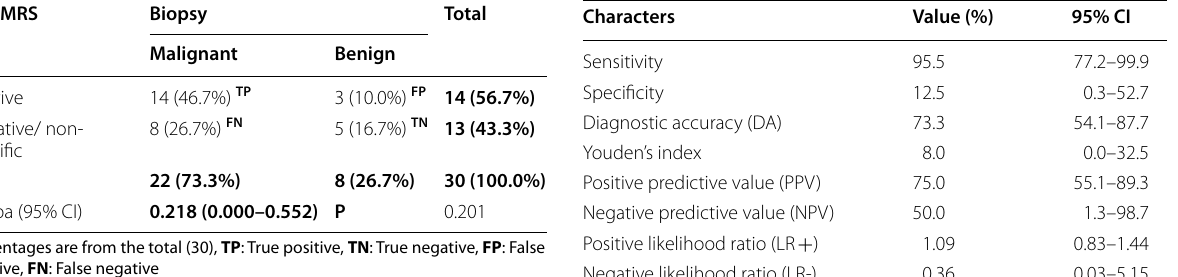
Table 10 Agreement between biopsy (reference) and MRI MRS